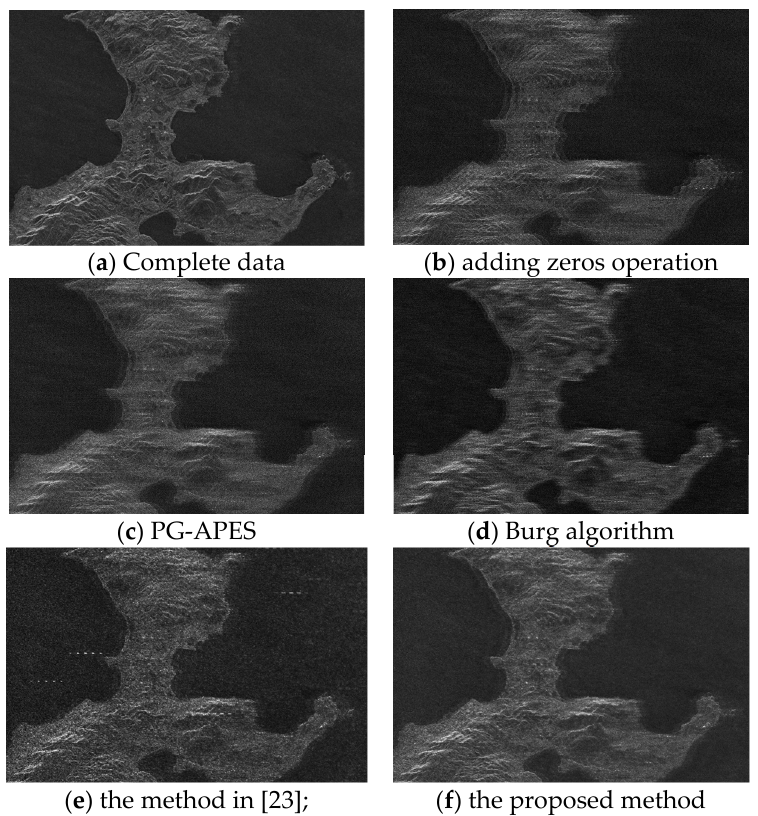
Figure 25. Results of Region 3: ( a ) complete data; ( b ) adding zeros operation; ( c ) PG-APES; ( d ) Burg algorithm; ( e ) the method in [23]; and ( f ) the proposed method.